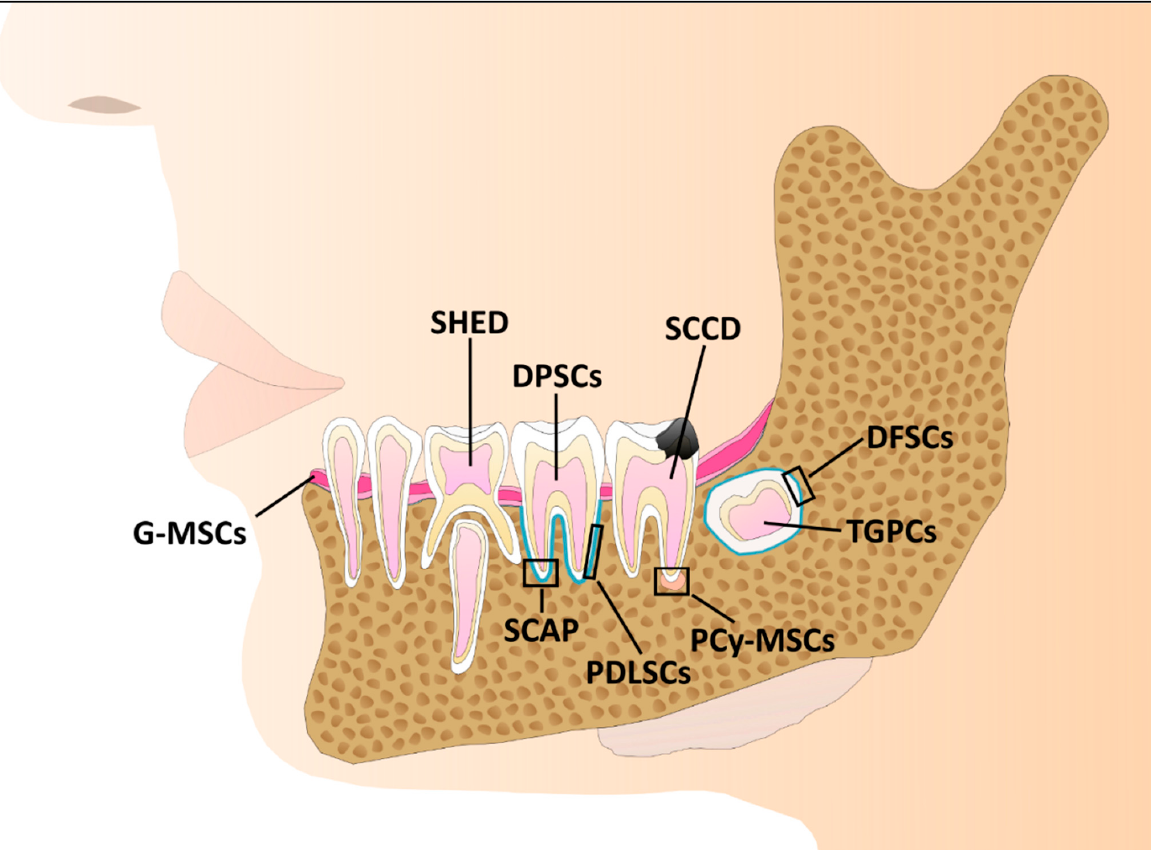
Figure 1. Overview of the stem cells with an oral and dental origin. The dental tissue is a rich source of multipotent and mesenchymal stem cells. Dental pulp stem cells (DPSCs), dental follicle stem cells (DFSCs), stem cells from exfoliated deciduous teeth (SHED), stem cells from the apical papilla (SCAP), periodontal ligament stem cells (PDLSCs), gingival mesenchymal stem cell (G-MSCs), tooth germ stem cells (TGSCs), mesenchymal stem cells from periapical cysts (PCy-MSCs), and dental pulp stem cells from carious deciduous teeth (SCCD) can be isolated from this